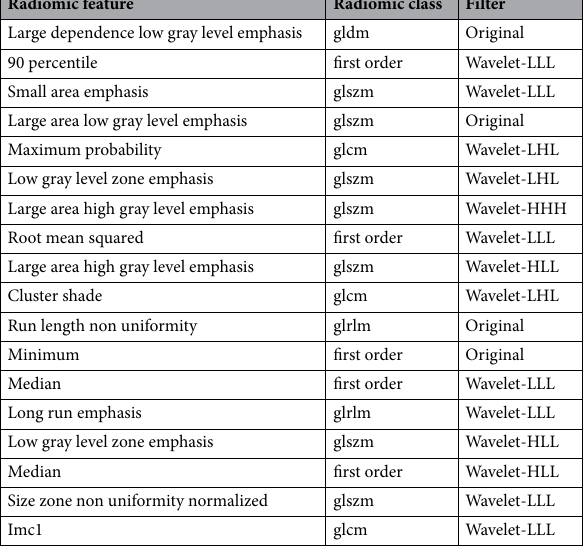
Table 4. Target image histology features and their feature classes and filters based on the SVM classifier model with the three-layer sketching method. GLDM = Gray Level Dependence Matrix; GLSZM = Gray-Level Size Zone Matrix; GLCM = Gray-Level Co-occurrence Matrix; GLRLM = Gray-Level Run Length Matrix.